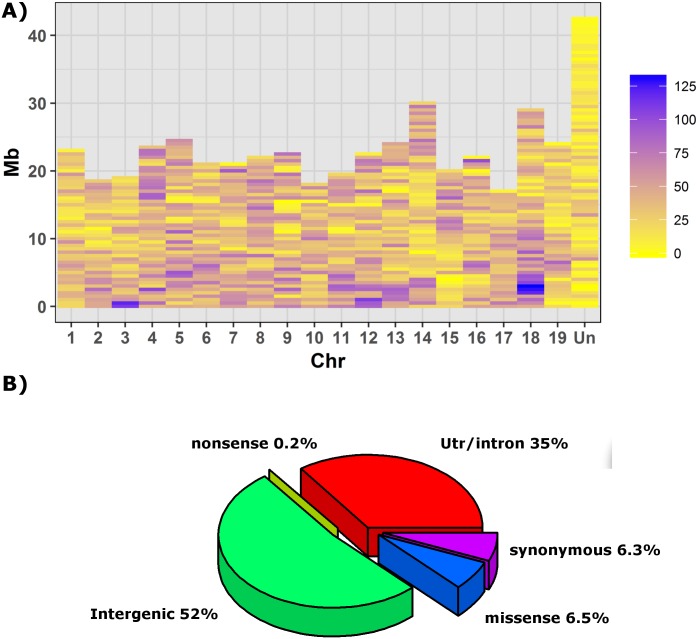
A) SNP density across the 12X grapevine reference genome PN40024. Each block represents a bin of 500kb. The bar “Un” shows SNPs found on unassembled genomic sequences. B) summary of SNPs annotation according to the grape gene annotation v2.1.